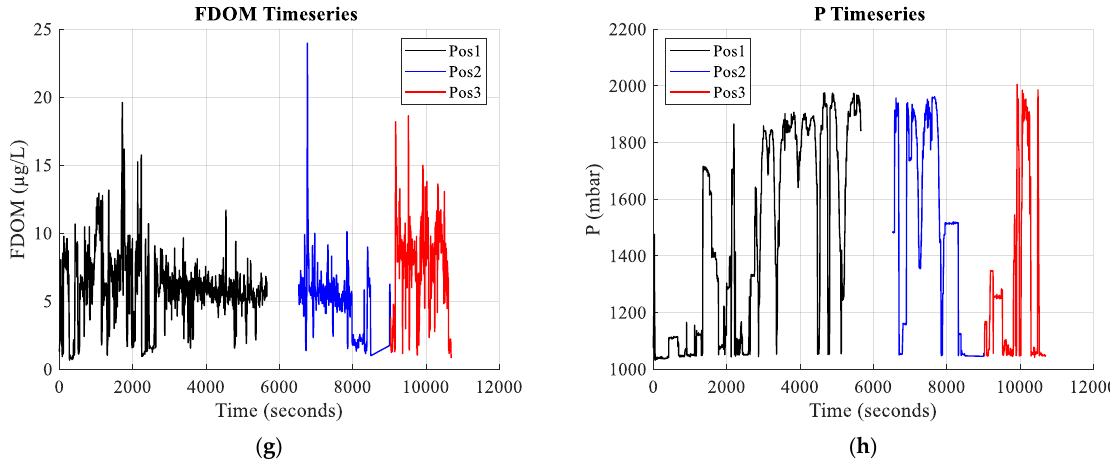
Figure 12. Time series of ( a ) temperature, ( b ) electric conductivity, ( c ) salinity, ( d ) dissolved oxygen, ( e ) pH, ( f ) oxidation- reduction potential, ( g ) dissolved organic matter fluorescence, and ( h ) pressure measurements recorded during in situ surveys. Data is split into different parts according to the boat positions given in Figure 8. No data were recorded during the transition to the second position. Hence a gap occurs in the data between time stamp 5667 and 6529. Table 5. In situ measurements statistical information summary, based on all data points recorded during ROV surveys. Pressure is not included in this table.